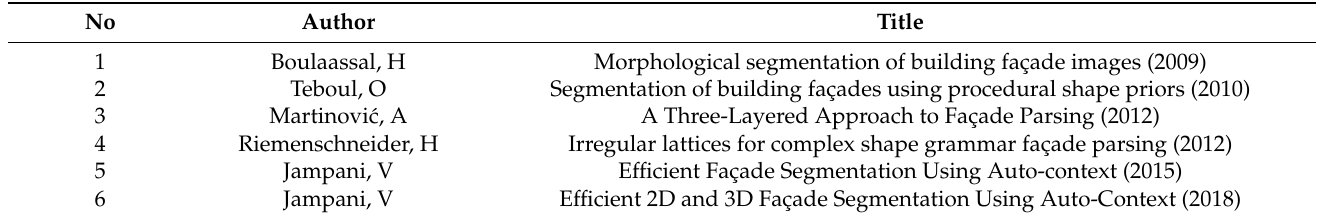
Table 2. Research related to façade segmentation.